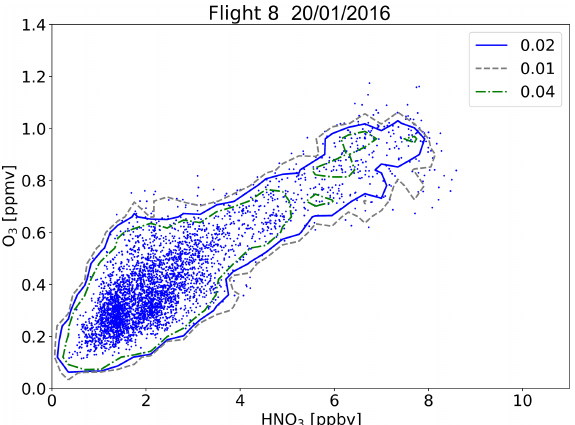
Figure 1. Correlation of HNO 3 with O 3 measured by GLORIA dur- ing flight 8 on 20 January 2016. The correlation is shown as single points and as a RNFD (solid, dashed and dash-dotted lines; see leg-